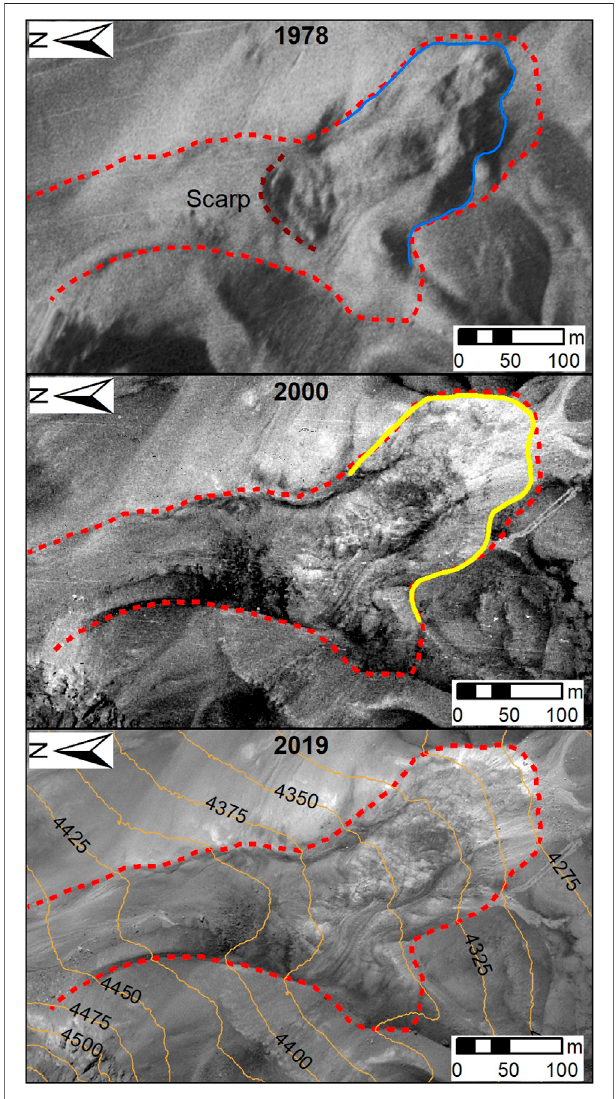
FIGURE 11 | Sequence of orthoimages for the El Cachito rock glacier. The front toe of the landform that could be identi fi ed is indicated in blue (1978) and yellow (2000). Red dashed line indicates the landform outline in 2019. Note thestrong changesin thesurface morphologyjust below thescarp between 1978 and 2000. © CNES (2018), and Airbus DS (2018), all rights reserved.